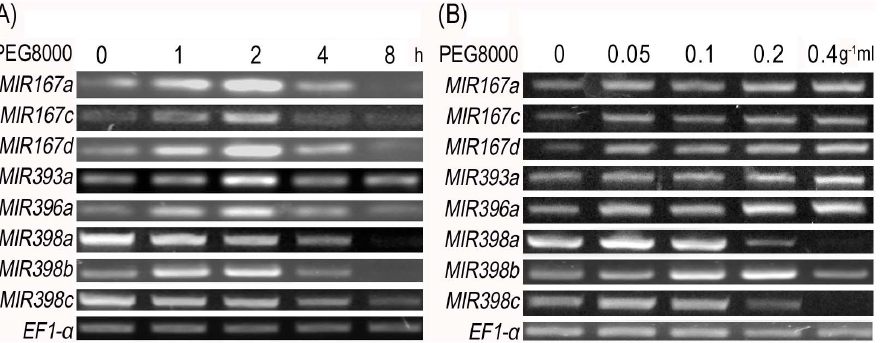
Figure 2. RT-PCR detection of miRNAs transcription in WT seedlings under PEG8000 stress. ( A ) miRNAs transcription detection in WT seedlings treated with 0, 1, 2, 4, 8 h using 0.01 g ml 2 1 PEG8000 treatment; ( B ) miRNAs transcription detection in WT seedlings after 2 h using different PEG8000 concentration treatments at 0, 0.05, 0.1, 0.2, 0.4 g ml 2 1 PEG8000. EF1- a was used as an internal control of RT-PCR.